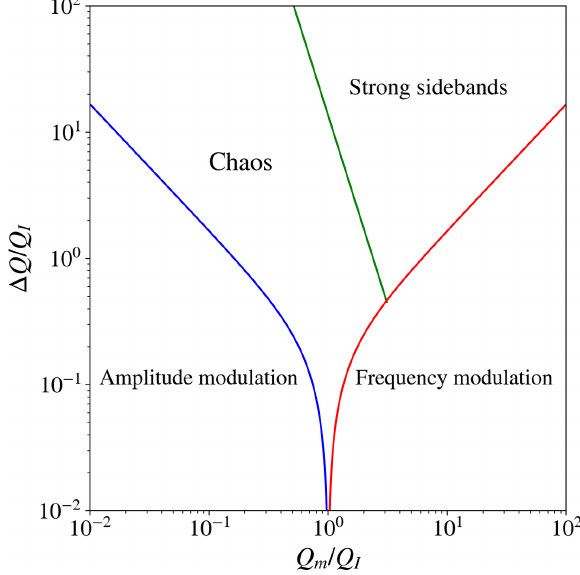
FIG. 1. The four regimes in the tune modulation parameter space for a modulation tune Q m , a modulation depth Δ Q , an island tune Q I [Eq. (9)] and the sixth-order resonance ( N ¼ 6 ) [17,32 – 34]. The blue, red, and green limits are computed from Eq. (10a), (10b), (10c),